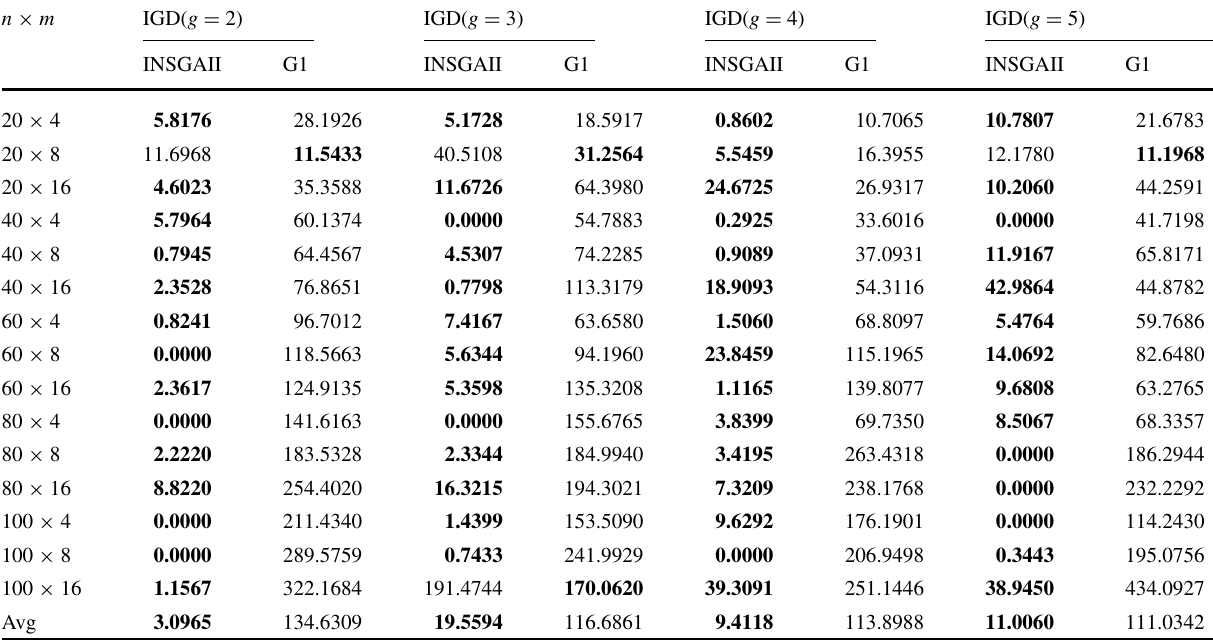
Table 5 Comparisons of the IGD values between INSGAII and